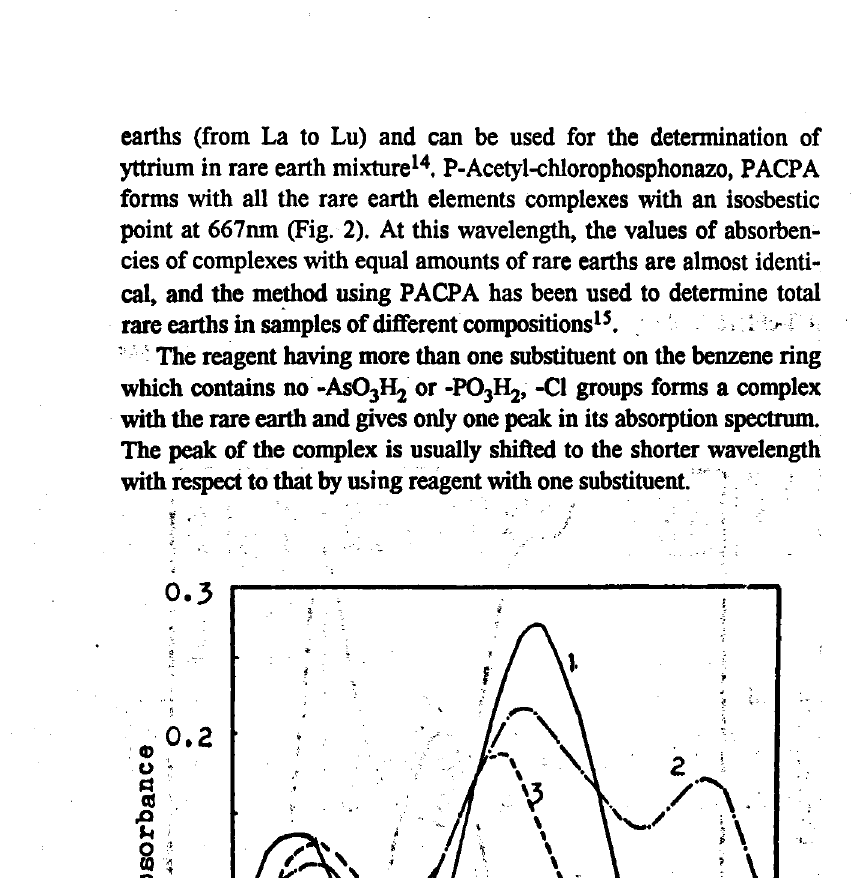
Fig. 2 Absorption spectra of PACPA complexes of rare earths: 1» Ce-PACPA; 2 , Y-PACPA; 3, YB-PACPA against reagent PACPA, 5.29 x 10-5M;